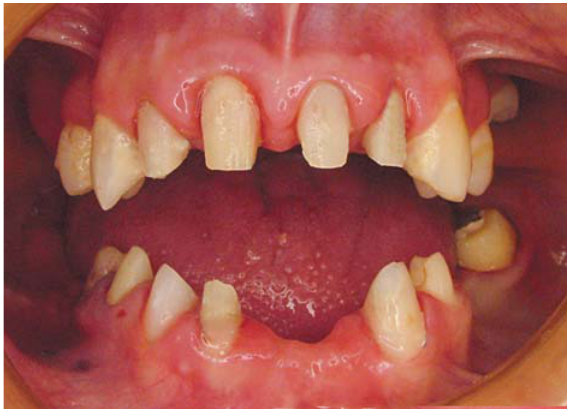
Figure 6- Clinical view of crown preparation